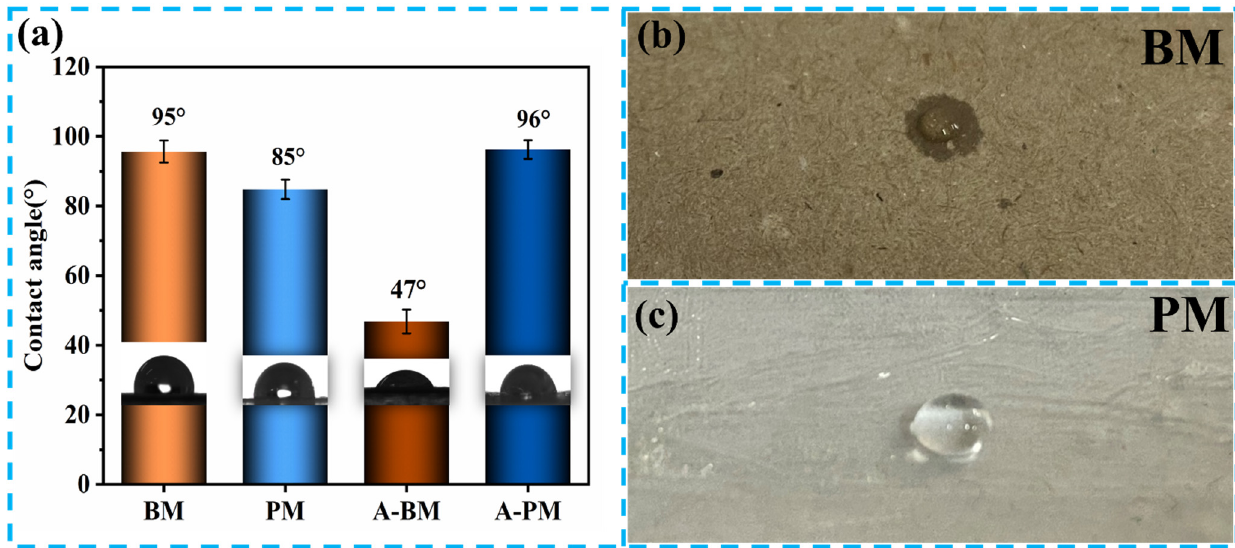
Figure 7. ( a ) Surface contact angle of BM and PM before and after dry heat aging; ( b ) physical image of BM; ( c ) physical image of PM.